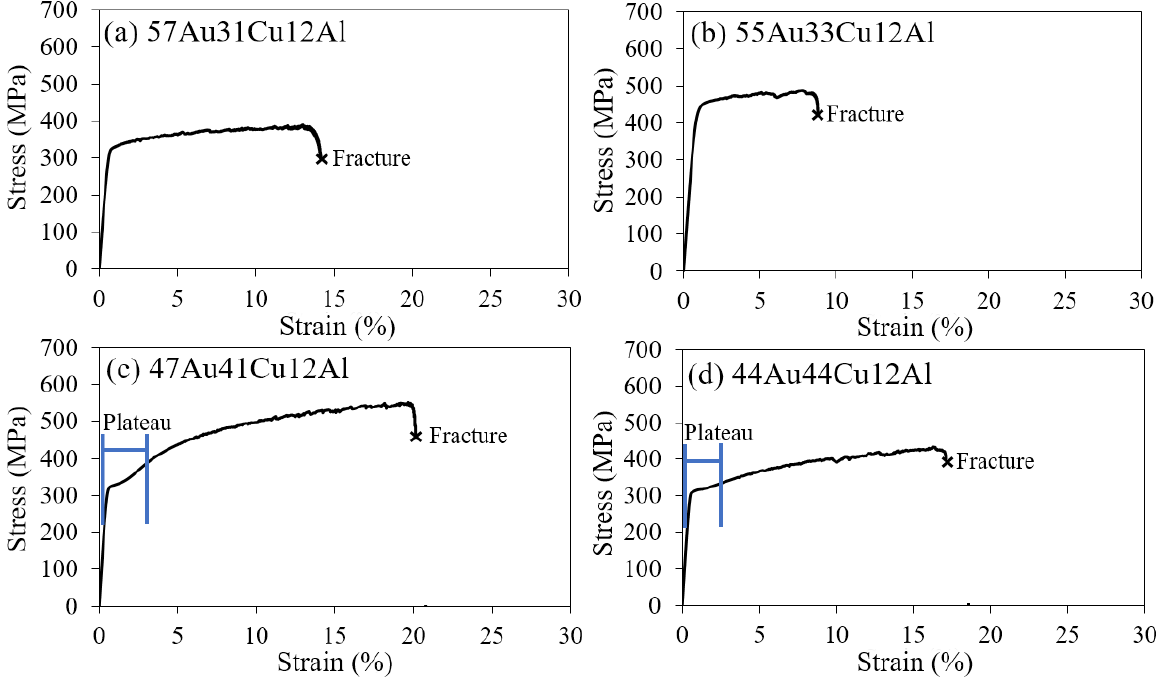
Figure 4. Stress–strain curves of the tensile tests of ( a ) 57Au31Cu12Al, ( b ) 55Au33Cu12Al, ( c ) 47Au41Cu12Al, and ( d ) 44Au44Cu12Al alloys at 293 K (±3 K). The cross symbols indicate the fracture of the specimens.